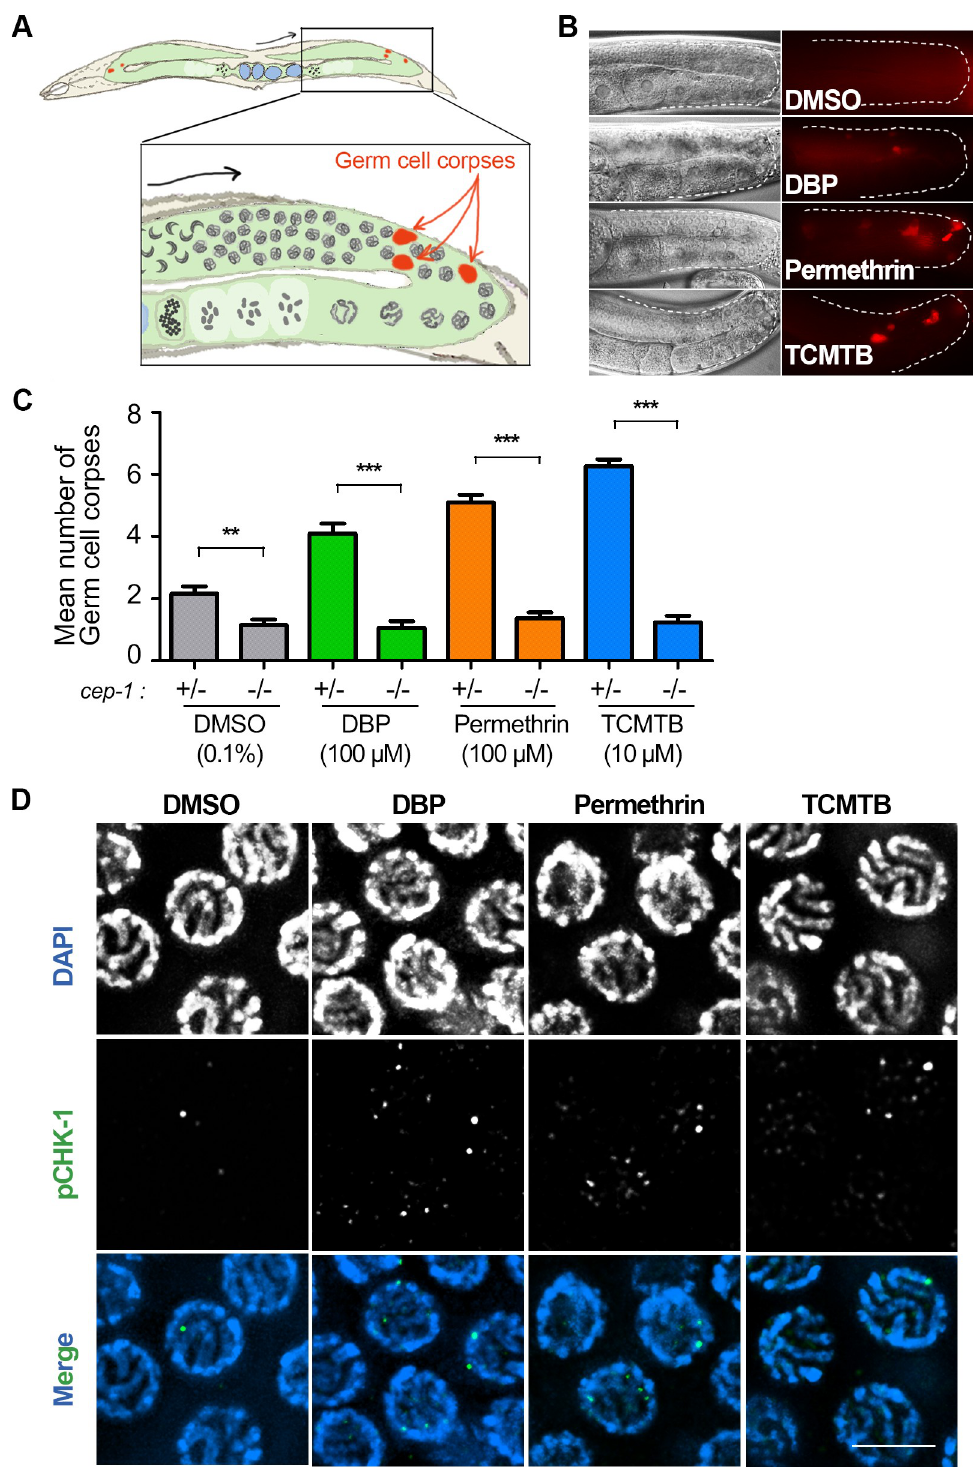
Fig 3. DBP, Permethrin, and TCMTB exposures lead to p53/CEP-1-dependent increased germ cell apoptosis and CHK-1 activation. (A) Schematic representation of C . elegans and the area where DNA damage checkpoint activation of germ cell apoptosis is detected in the germline. Inset represents zoom-in of one gonad arm. Black arrow indicates orientation of progression through meiosis while red arrows indicate germ cell corpses (red) observed at late pachytene near the gonad bend. (B) Chemical exposures caused a significant increase in the number of germ cell corpses observed at late pachytene compared to vehicle alone. Gonads are traced to facilitate visualization. On the left is the Nomarski